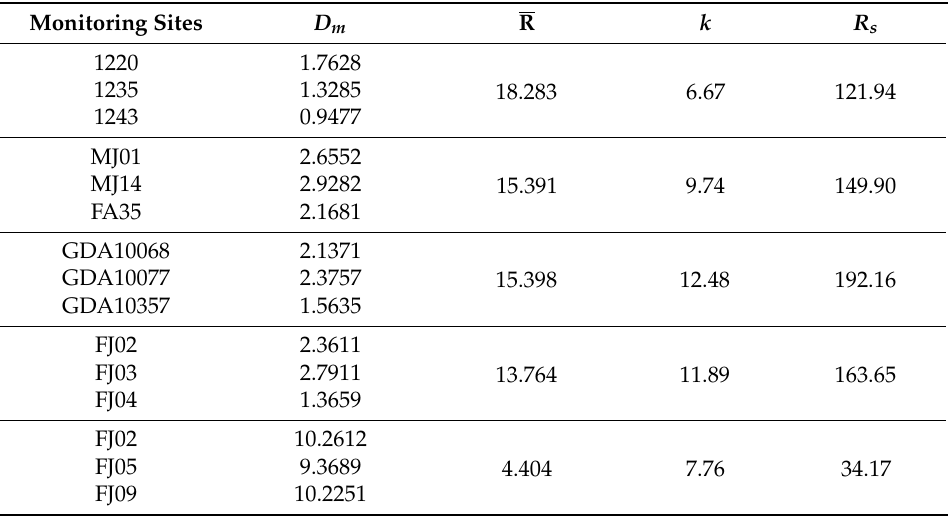
Table 3. Time domain measurement parameters of monitoring points in landslide areas. Monitoring